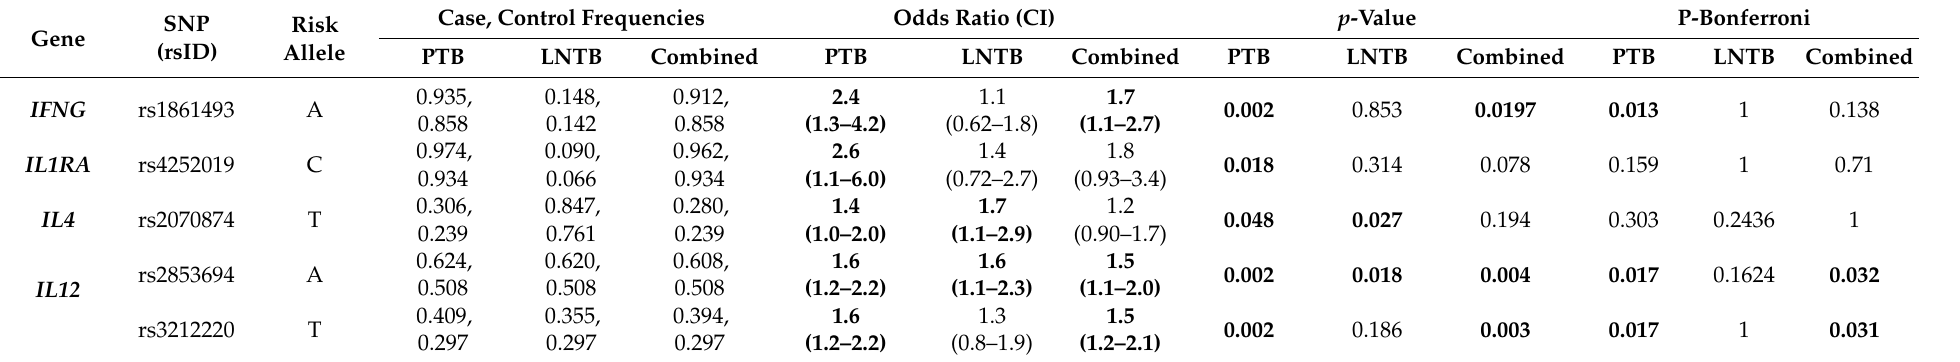
Table 3. Comparative allelic association of the cytokine gene variants in the validation panel between PTB and